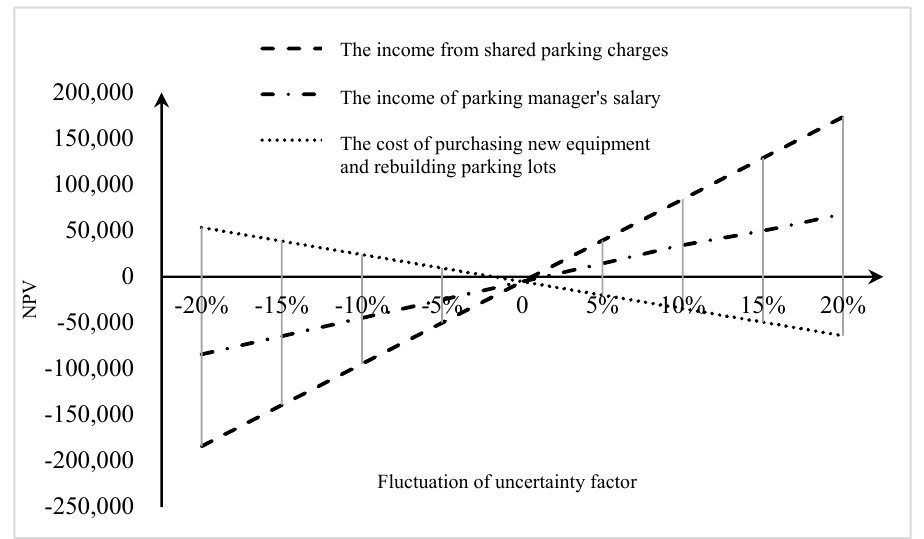
Figure 2. Sensitivity analysis of the NPV in residential areas.